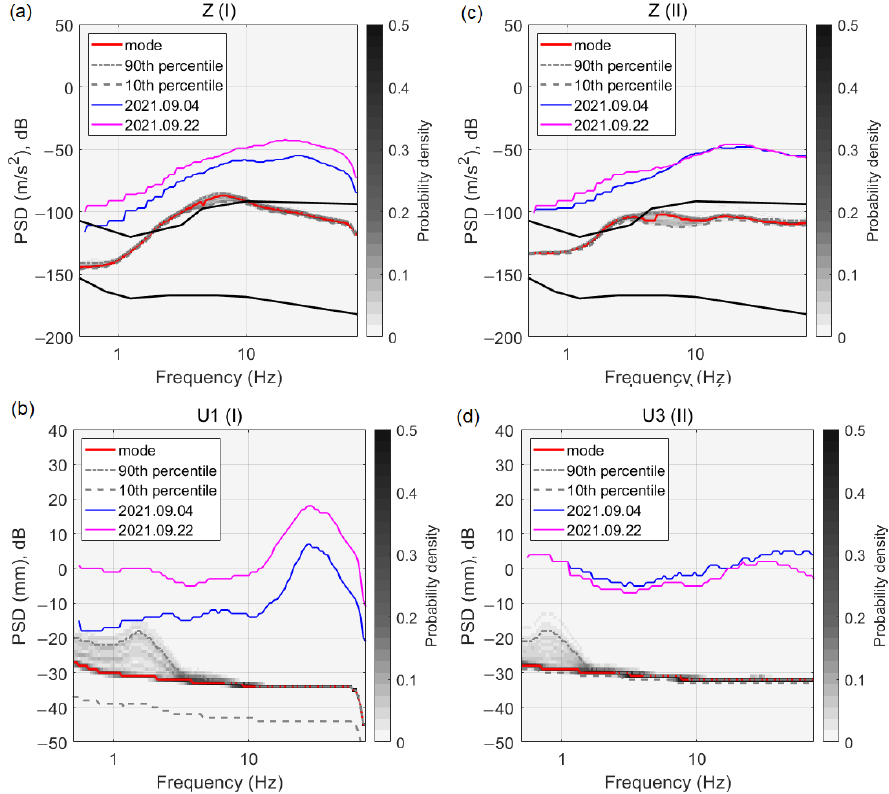
139 m/kg 1/3 is by ~12 dB higher than the hydrogeological response recorded during the 348